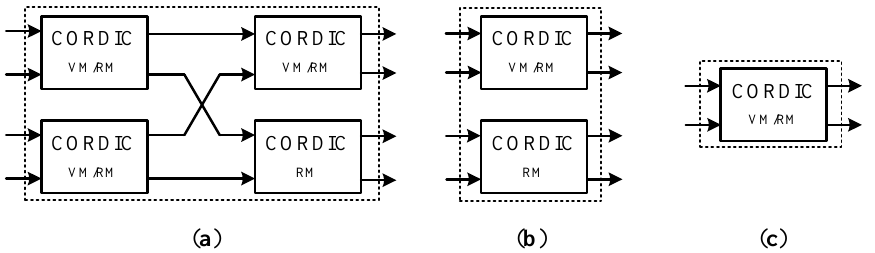
Figure 7. Block diagram of processing engine#4.